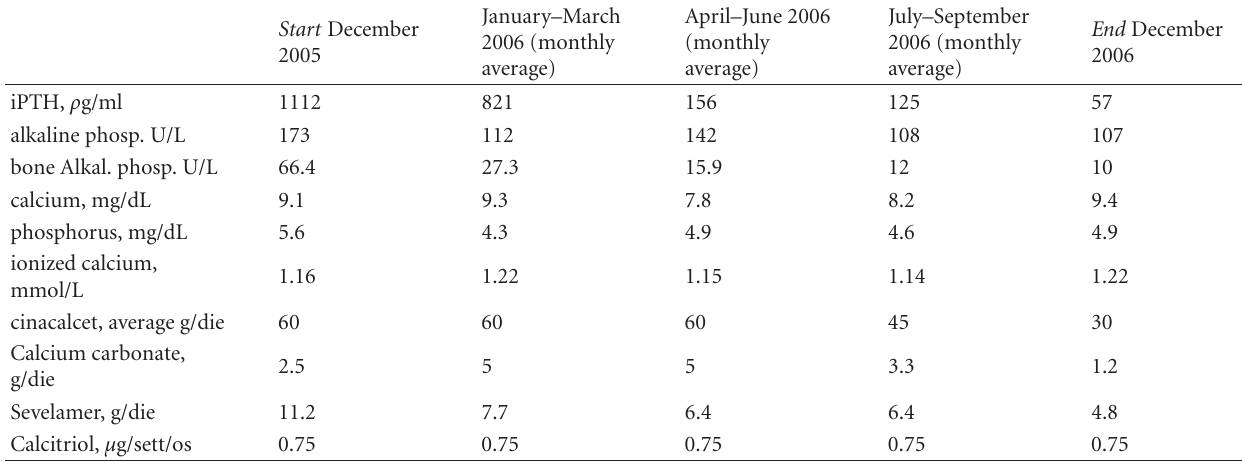
Table 1: Outcome of haematochemical and therapeutic